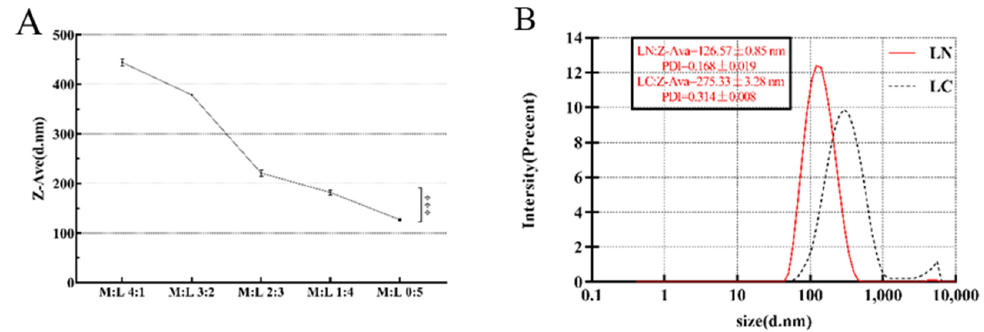
Figure 1. Effect of MCT concentration on the emulsion droplet size of LN. ( A ) Z-Ava values (d. nm) of LN at various M:L (4:1, 3:2, 2:3,1:4 and 0:5) ratios. *** represented p < 0.001. M:L represented for MCT: Linalool. ( B ) Z-Ava value (d. nm) and PDI value of LN and LC at the ratio of M:L